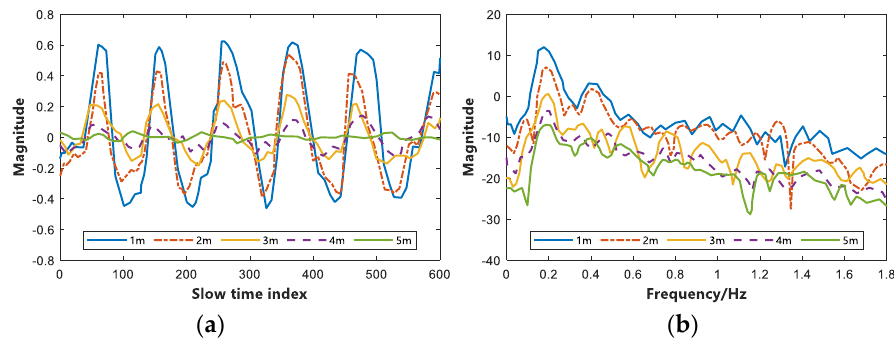
Table 2. Vital signs errors and SNR at different distances parameter setting of IR − UWB radar.